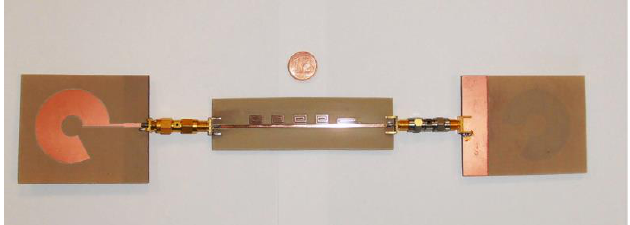
Figure 9 Photograph of a five-bit chipless tag equipped with two broadband circular polarized antennas.